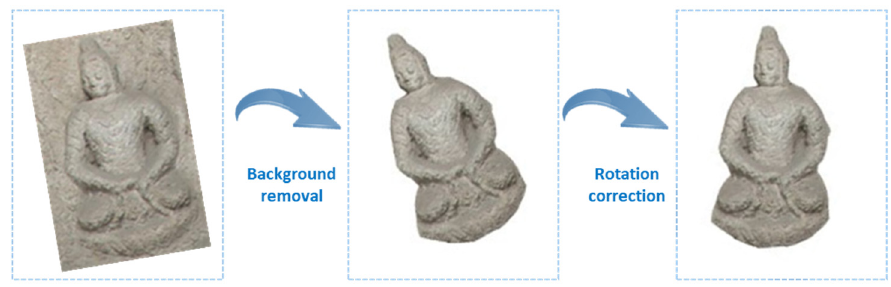
Figure 3. Rotation of preprocessed and segmented image of Buddhist statues.